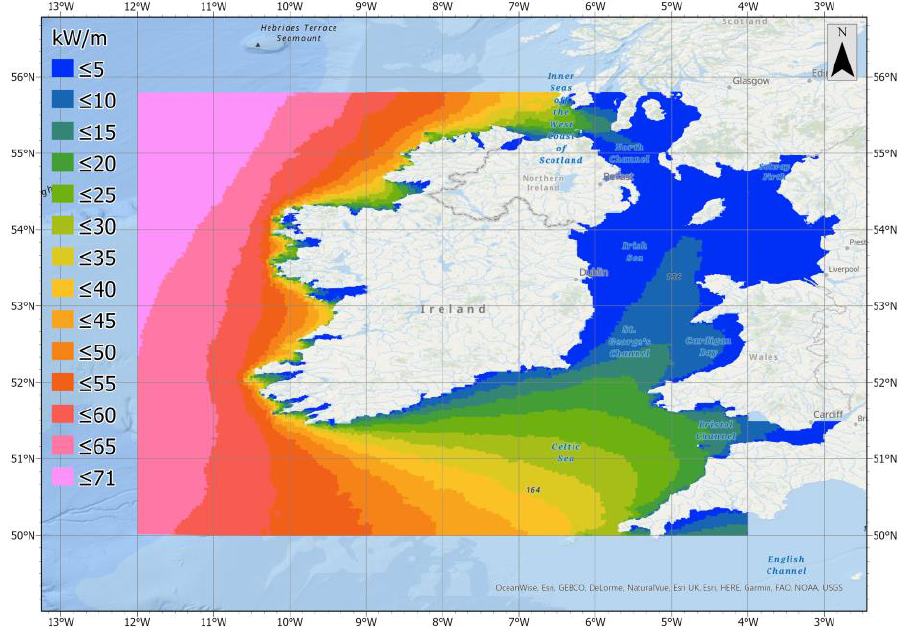
Figure 8. The annual mean wave power resource in kW per linear metre of wave crest (kW/m).